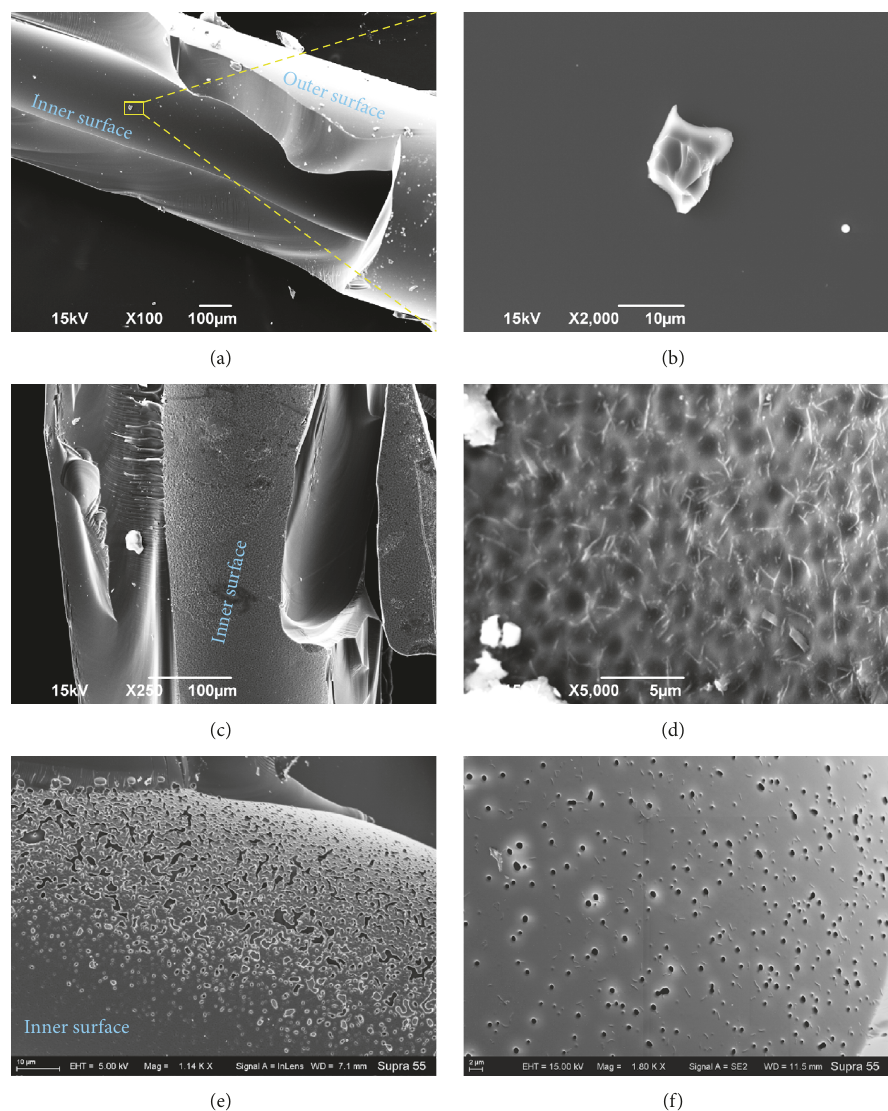
Figure 8: SEM images of the inner surface of the silica tube. (a) Smooth inner surface before the reaction; (b) magnification of the square area shown in (a); (c) dissolution pits on the inner surface after heating at 200 ∘ C for ∼ 60 days; (d) magnification of (c); severe erosion of the silica on the inner surface of FSCCs containing (e) 1.0 m Na 2 SO 4 and (f) 1.0 m Li 2 SO 4 after heating at 350 ∘ C for